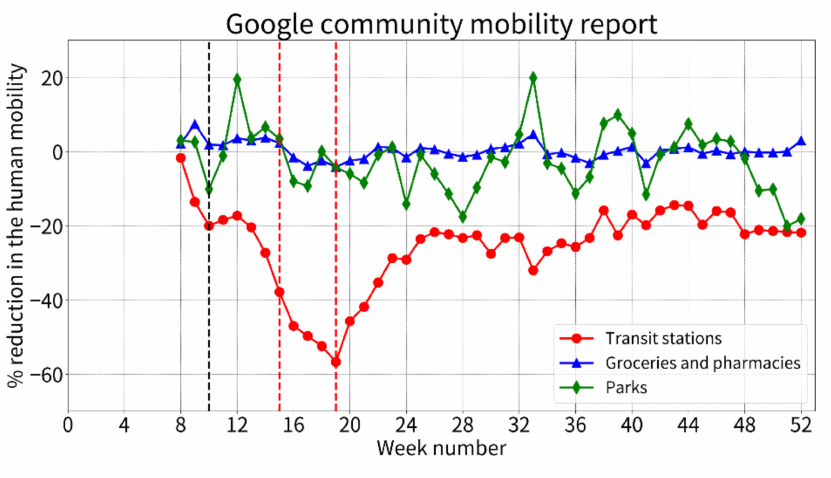
Figure 1. The weekly percentage reductions in human mobility in 2020 (5th–52nd weeks). The percentage reductions in human mobility represent the mean values for each week compared with the baseline 5-week period (3 January to 6 February 2020). The initiation of the nationwide school closure at the 10th week is highlighted by a black dashed line and the national State of Emergency from the 16th to 19th weeks is shown by the red dashed lines. The schools typically reopened after the State of Emergency was officially lifted in the 19th